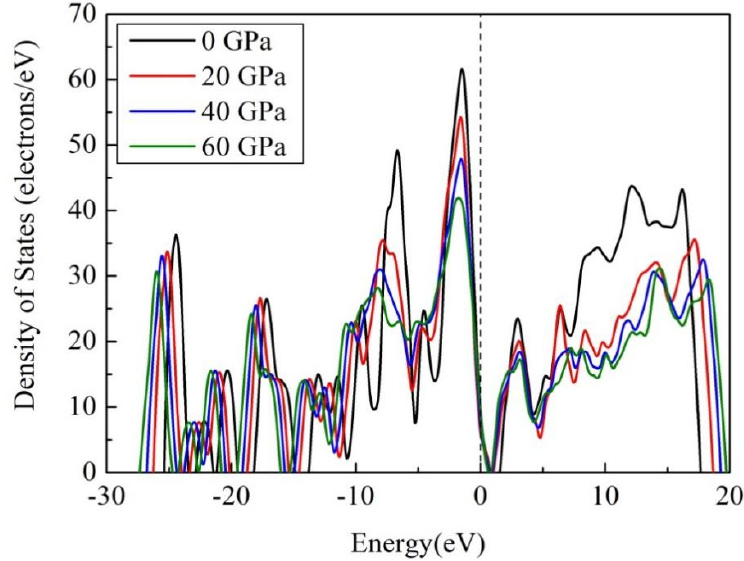
Figure 6. The density of states of DNTF under different pressure.